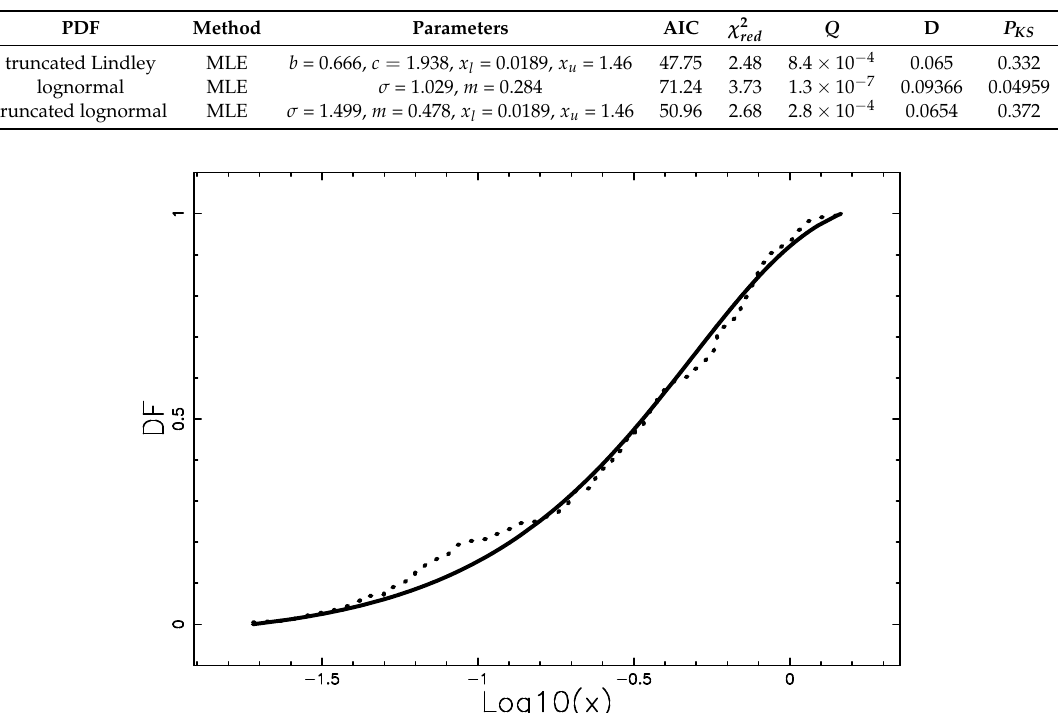
Table 1. Statistical parameters of NGC 6611 (207 stars + BDs) in the case of the truncated Lindley distribution. The number of linear bins, n , is 20.